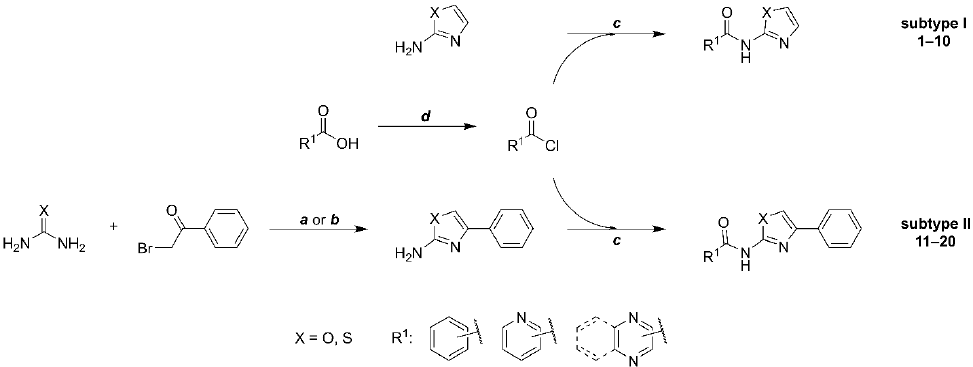
Figure 2. Synthetic procedure used to prepare title compounds. Conditions: a: (for X = S) 1.1 eq. urea, in EtOH, reflux 2 h; b: (for X = O) 10 eq. urea, in MeCN, reflux 16 h or in DMF, 120 ◦ C 2 h; c : 1 eq. acyl chloride, 3 eq. DIPEA or pyridine, in DCM, overnight; d : 10 eq. thionyl chloride, catalytic Table 1. Structures, log k’ w , HepG2 cytotoxicity, and MIC against Mtb H37Ra of the title com- pounds.